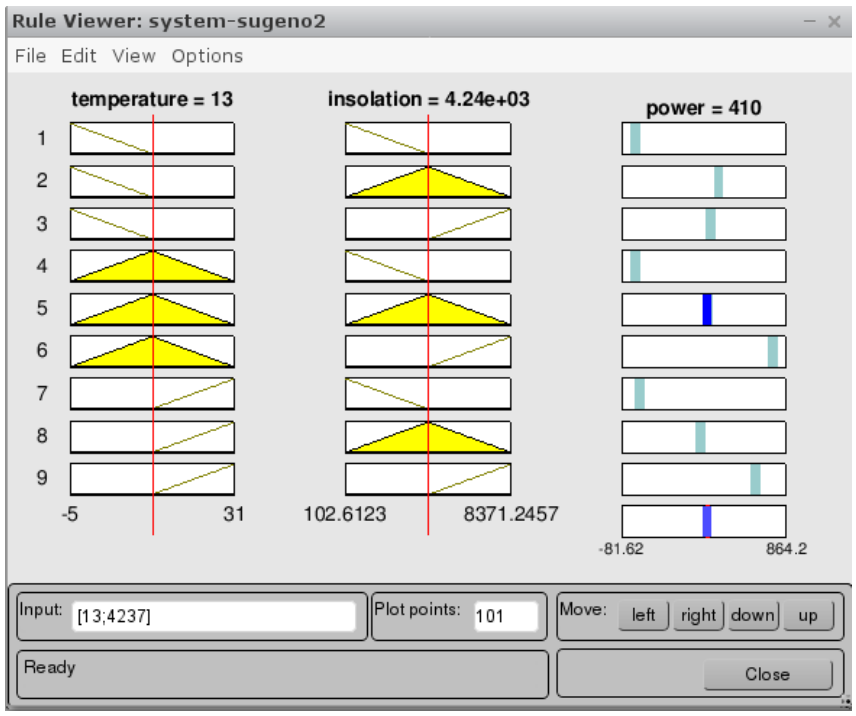
Figure 4. The draft rule system based on ANFIS.